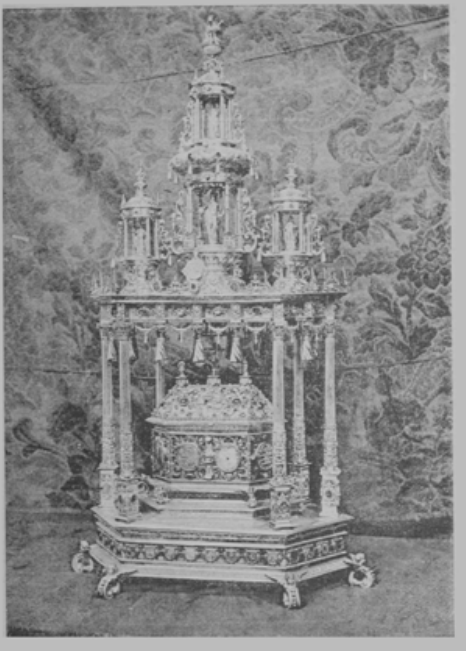
Figure 12. Anonymous. Reliquary of the Holy Blood in Bruges La Morte